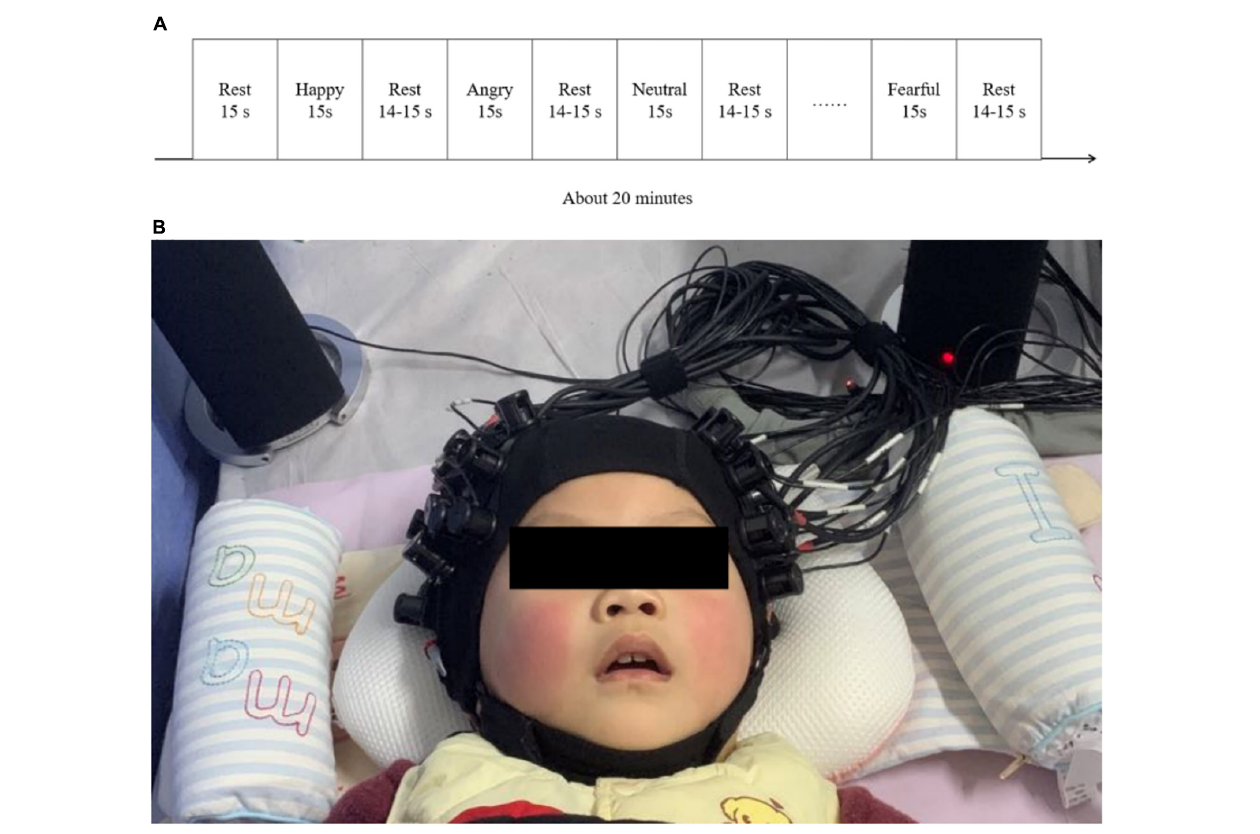
FIGURE 1 | fNIRS test procedures and environment. (A) A schematic representation of the block design used for the vocal emotional stimulation experimental procedure. (B) An example of the positioning of the participants during the fNIRS test. The test was conducted in a dark environment, and the lights in the room were switched